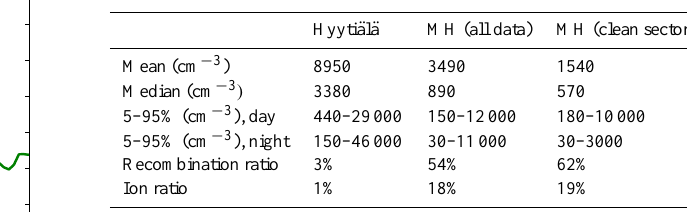
Table 1. Characteristics of nano-CN concentrations in Hyyti¨al¨a and Mace Head (MH). The recombination ratio is the maximum esti- mate of recombination products divided by the neutral nano-CN. The ion ratio is the fraction of ions from all particles between 1.3–